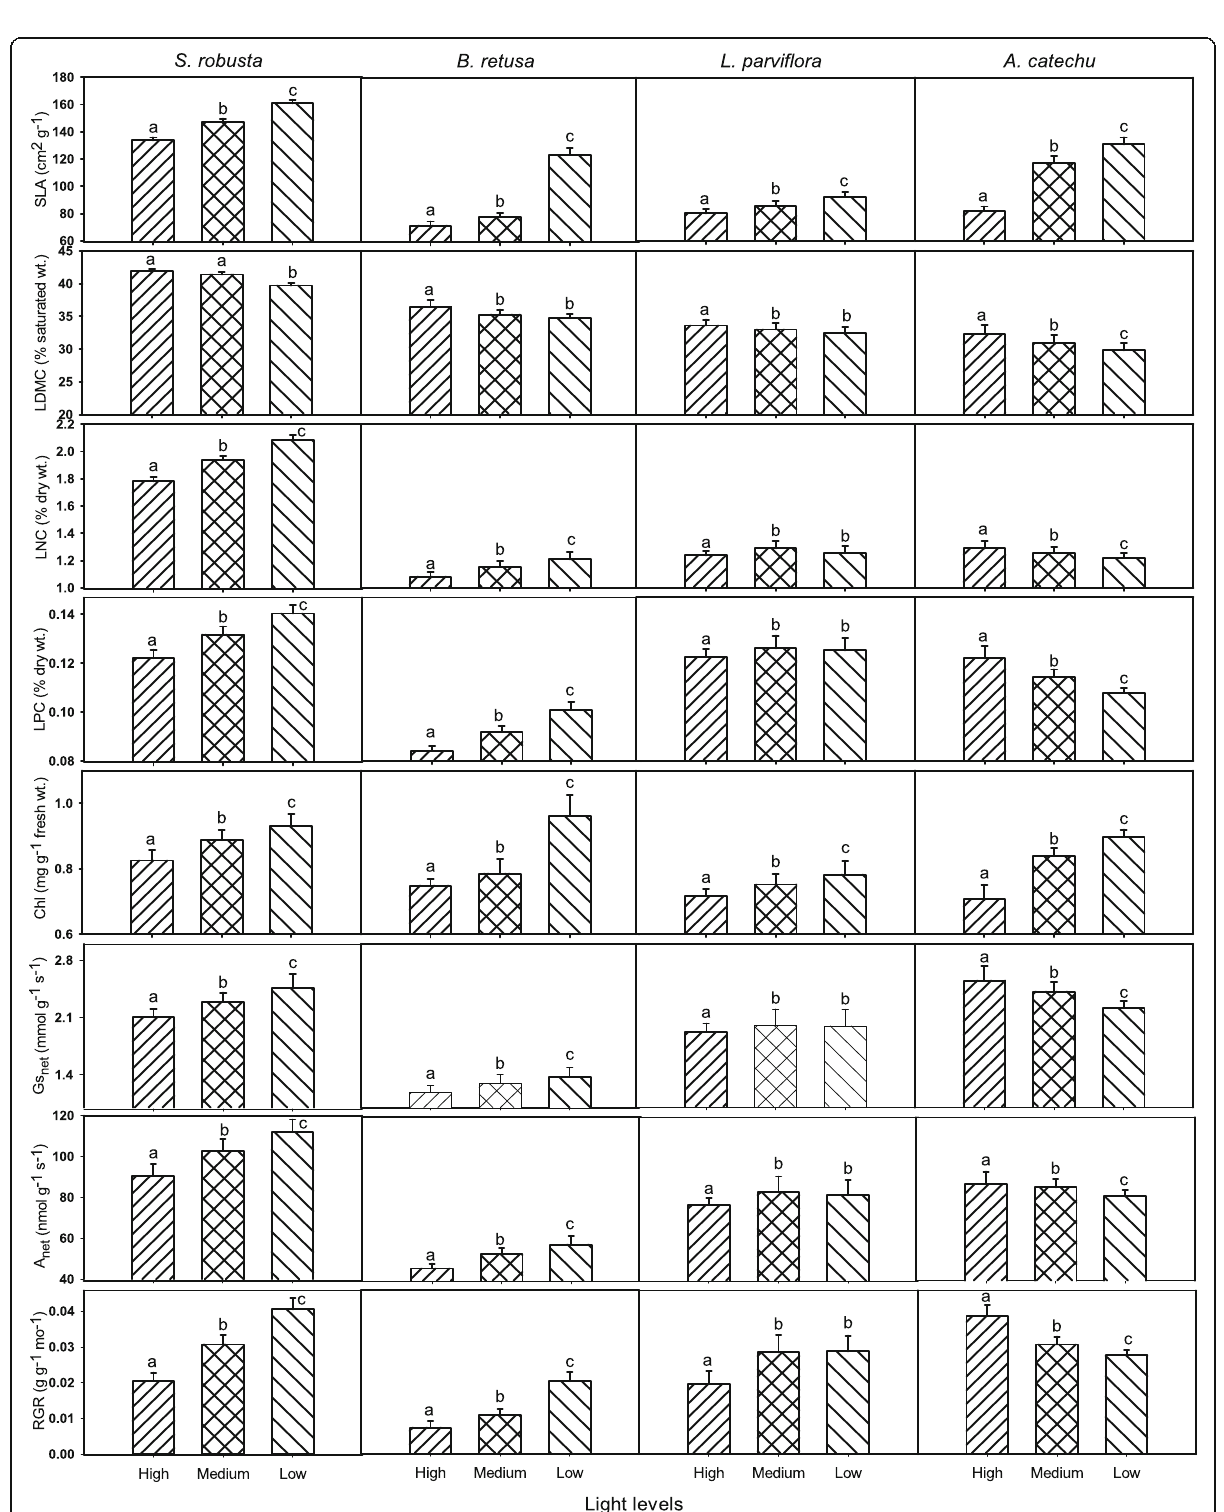
Fig. 5 Mean values of growth traits in seedlings of four tree species across sites and season at different light levels. SLA, specific leaf area; LDMC, leaf dry matter content; LNC, leaf nitrogen concentration; LPC, leaf phosphorus concentration; Chl, chlorophyll concentration; Gs net , net stomatal conductance; A net , net photosynthetic rate and RGR, relative growth rate. Different letters above the bars indicate significant differences after Tukey ’ s post hoc test ( a =